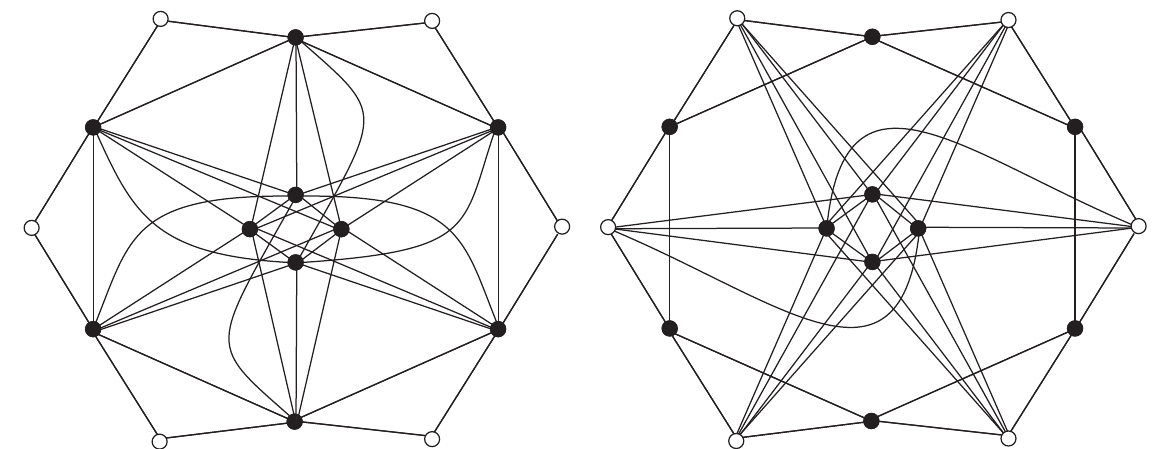
Figure 1: The R -vertex join (a) and R -edge join (b) of graphs C